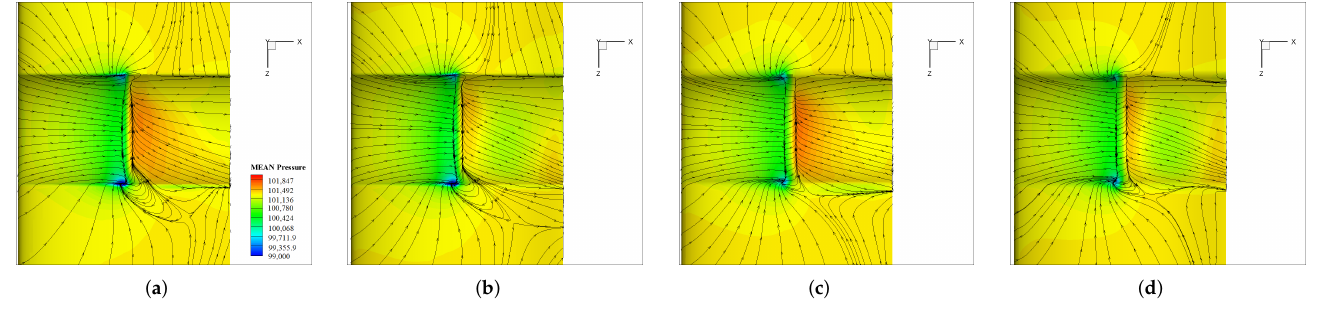
Figure 7. Pressure contours at wing upper surface from Momentum Source Method (MSM) and Sliding Mesh (SLM). ( a ) Config-2(SLM); ( b ) Config-1(SLM); ( c ) Config-2(MSM); ( d )